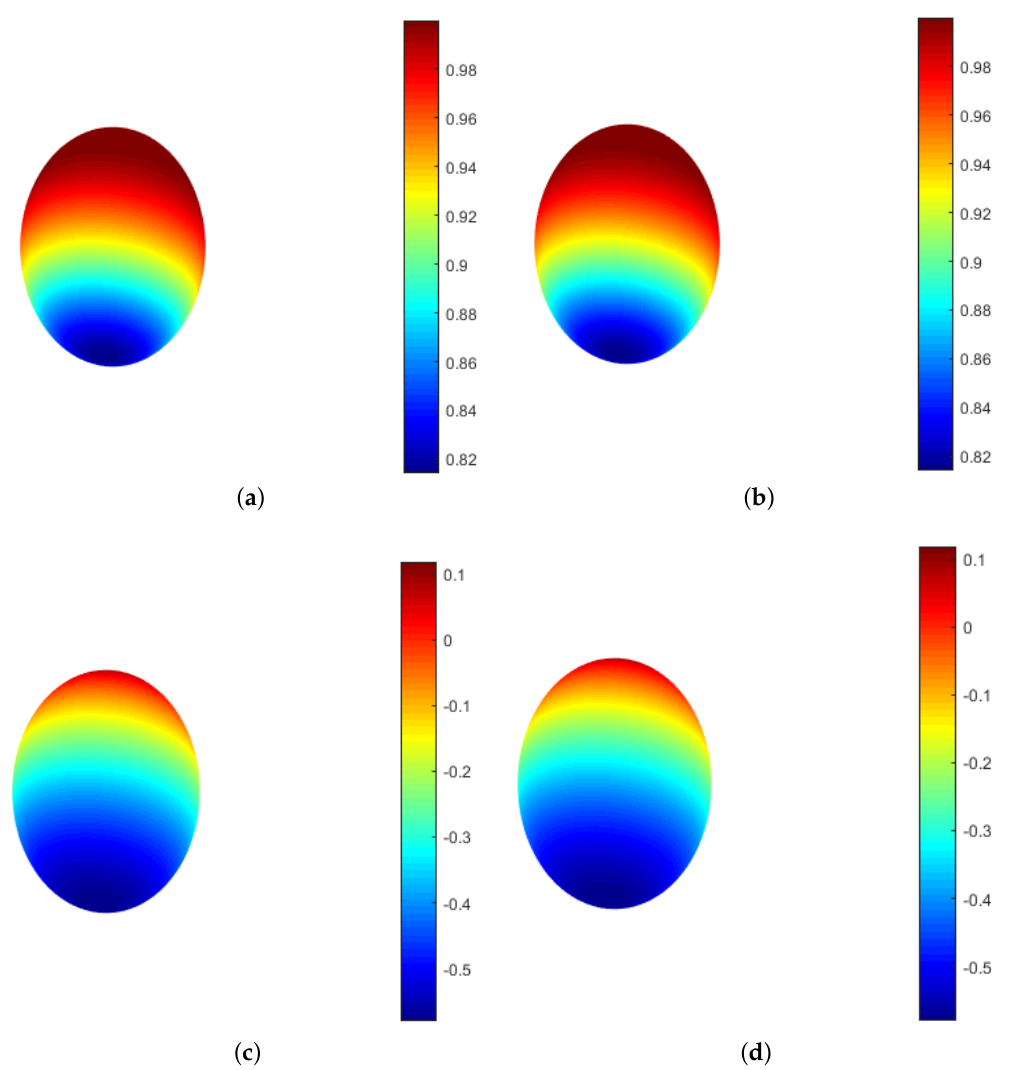
Figure 6. Plot of the exact solution ( a ) and plot of the approximate solution ( b ) related to u , and plot of the exact solution ( c ) and plot of the approximate solution ( d ) related to v with TPS for Example 2 by taking dx = 1